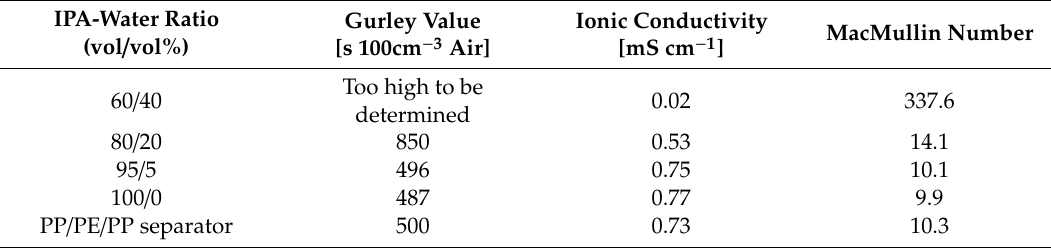
Table 1. Gurley value, ionic conductivity, MacMullin of a PP / PE / PP separator and CNT separators as a function of the IPA-water composition ratio [46]. Copyright (2012) ROYAL SOCIETY OF